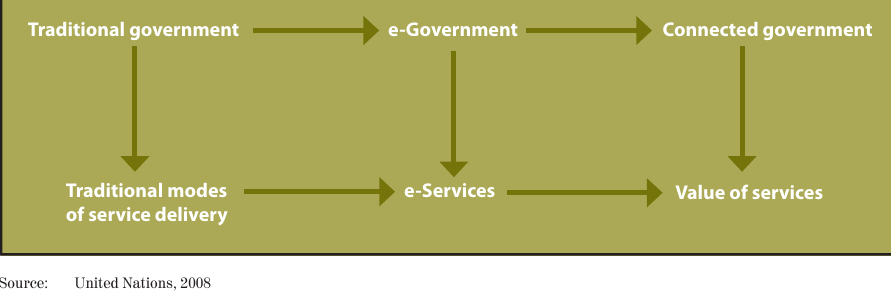
FIGURE 2: EVOLVING APPROACH TO PUBLIC SERVICE DELIVERY Traditional Adoptionn